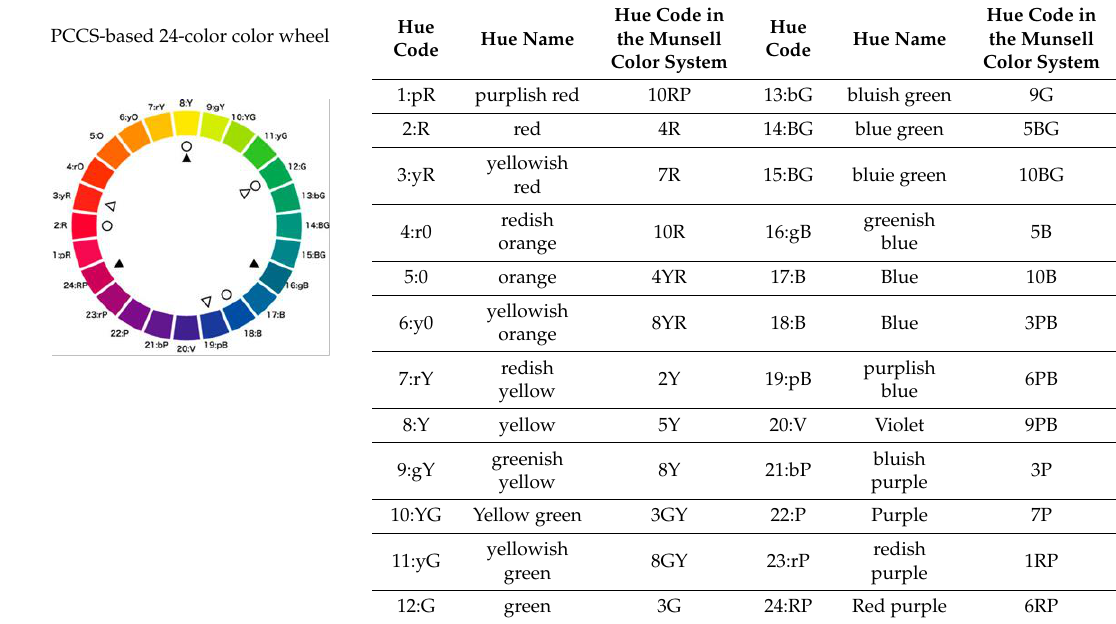
Hue Code in Hue Code in Hue Hue Hue Name the Munsell Hue Name the Code Code Color System